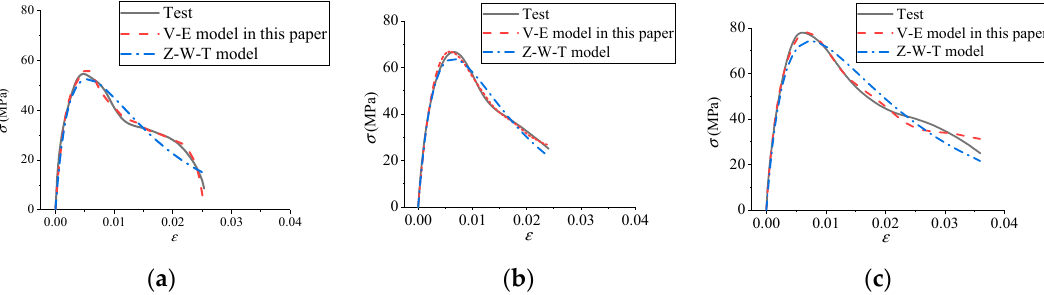
Figure 12. Comparison results of constitutive model curves under FT0. ( a ) 5.4 m/s; ( b ) 8.8 m/s; ( c ) 11.3 m/s.